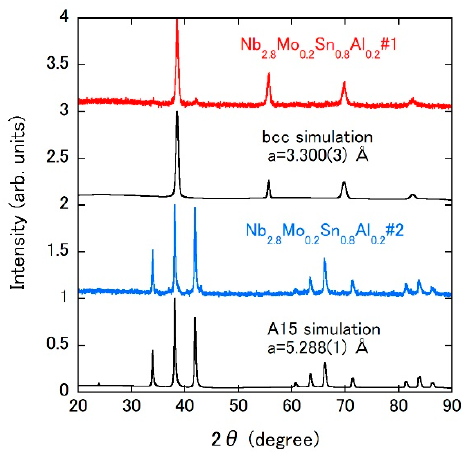
Figure 8. X-ray diffraction (XRD) patterns (Cu-K α ) of Nb 2.8 Mo 0.2 Sn 0.8 Al 0.2 #1 and #2. The simulation patterns of bcc and A15 phases are also shown. Each pattern is shifted by an integer value for the clarity. The lattice parameters were determined with the help of the Rietveld refinement program [38,39]. Table 4. Superconducting properties, δ , VEC and e / a of multisite HEA superconductors. T c and H c2 (0) data are from the references listed in the